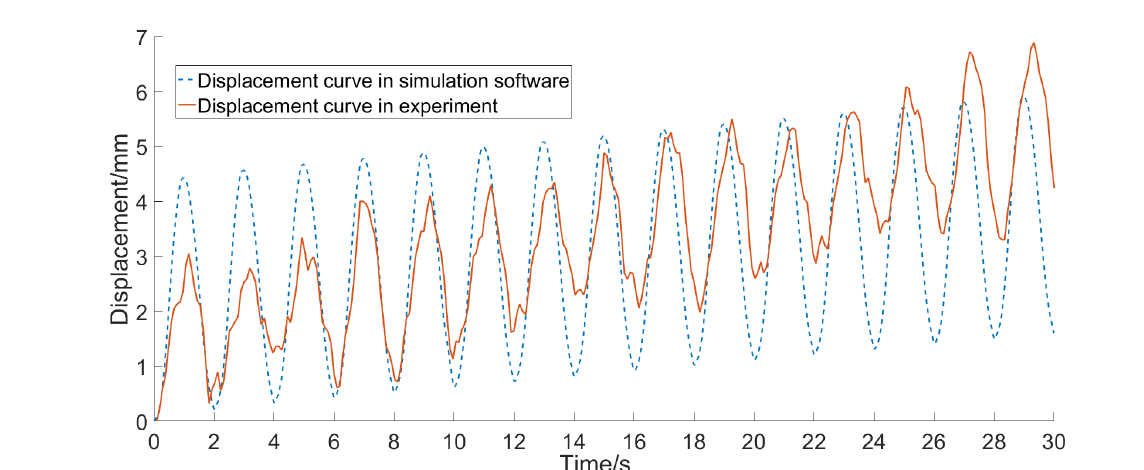
Figure 17. Comparison between simulation and experiment displacement curves of snake configuration.